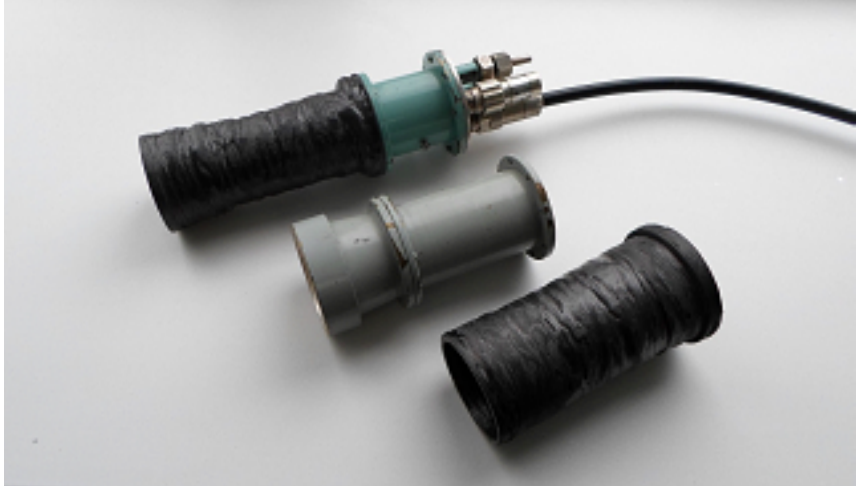
Figure 7. View of C -range horn antennas made from fabric (right), metal (center) and fiber (equipped with elements for antenna feeding,